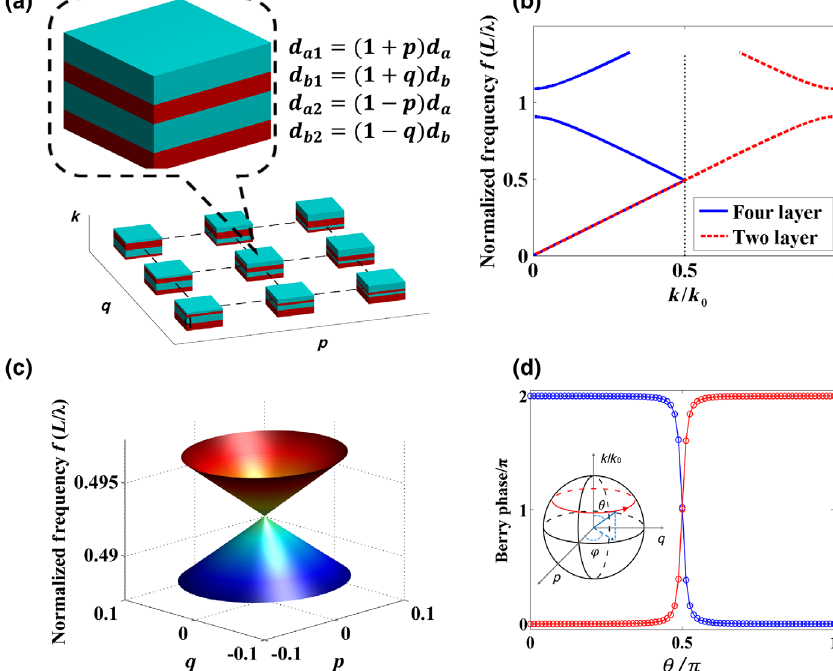
FIG. 1. Realization of Weyl points in a parameter space. (a) Photonic crystals (PCs) with different p , q values. The p , q form a parameter space. The inset shows one unit cell of the PC, where the first and the third layers are made of H the fourth layers are made of S O 2 (red). The thickness of each layer depends on its position in the p - q parameter space. (b) The band i dispersion of PCs with different unit cells (red line for a PC with only two layers and blue line for a PC the unit cell of which consists of two unit cells used for the red line). Here, d a ¼ 97 nm and d b ¼ 72 nm. (c) The dispersion of PCs in the p - q space with k ¼ 0 . 5 k 0 , and k π = ð d d 0 ¼ a þ b Þ . Here, two bands form a conical intersection. Panels (b) and (c) together show that the band dispersions are linear in all directions around the degeneracy point, indicating that it is an analogue of the Weyl point. (d) Berry phases defined on the spherical surface with a fixed θ (see the inset), where blue and red represent Berry phases on the lower and the upper band, respectively. The radius of the sphere is